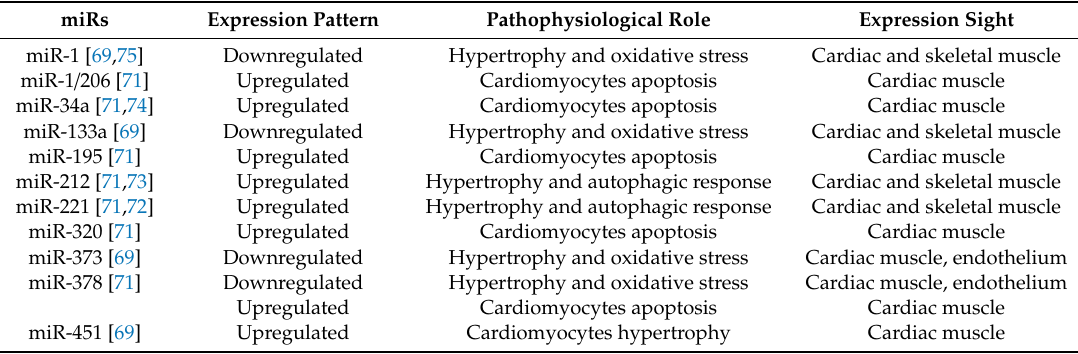
Table 1. Role of main miR candidates in DCM mechanisms and